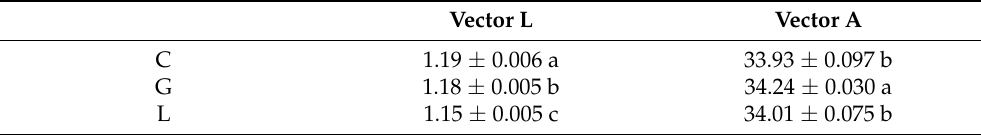
Table 3. Stoichiometric vector analysis of three planting cover types of soil. Different lowercase let- ters indicate significant differences according to Duncan's test ( p < 0.05).